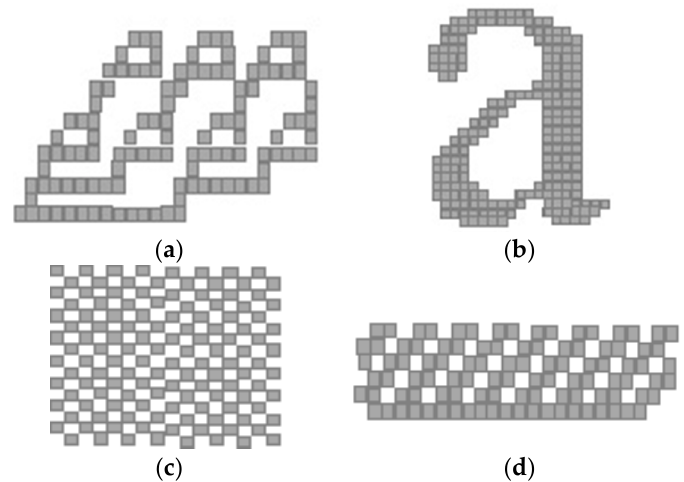
Figure 5. Example of patterns that maximize ( a , b ) the length of collision chains, and ( c , d ) the number of labels and/or collisions.